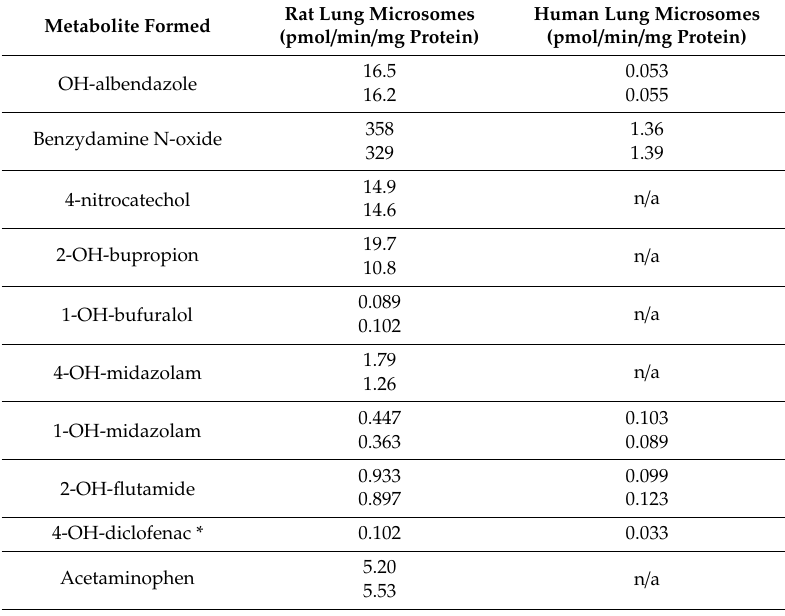
Table 3. Rat and human lung microsomal rates of metabolite formation for selected CYP and FMO substrates. Legend: n / a, not applicable (below limit of quantification).